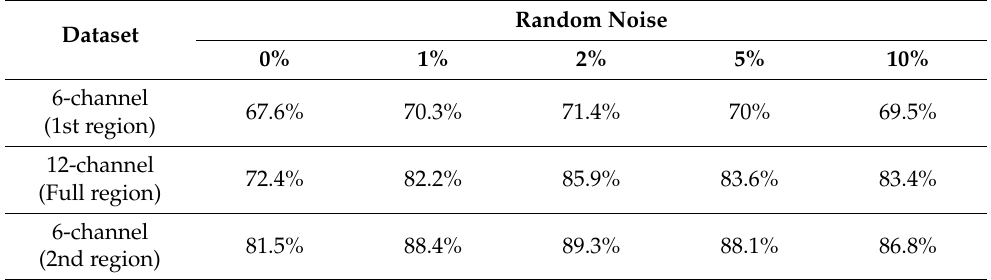
Table 4. Accuracy of optimized model evaluated by testing dataset after